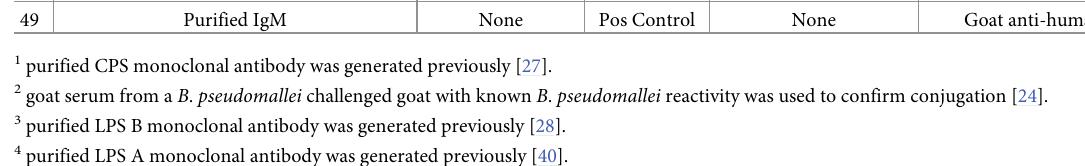
(Table 1). The selected melioidosis and non-melioidosis serum samples (n = 188) were used to detect patient reactive IgG or IgM antibody responses (Fig 2). For culture confirmed melioido- sis samples, reactivity of several antigens for IgM was lower compared to IgG reactivity in the same samples. For IgG and IgM reactivity, a subset of antigens had a lower reactivity in the negative samples and a high reactivity in the melioidosis patient samples at both time points. These antigens include LPSB, CPS, GroEL (BPSL2697), GroEL2 (BPSS0477), AhpC (BPSL2096), OmpA (BPSL2522) and BPSL1652. In contrast, antigens such as